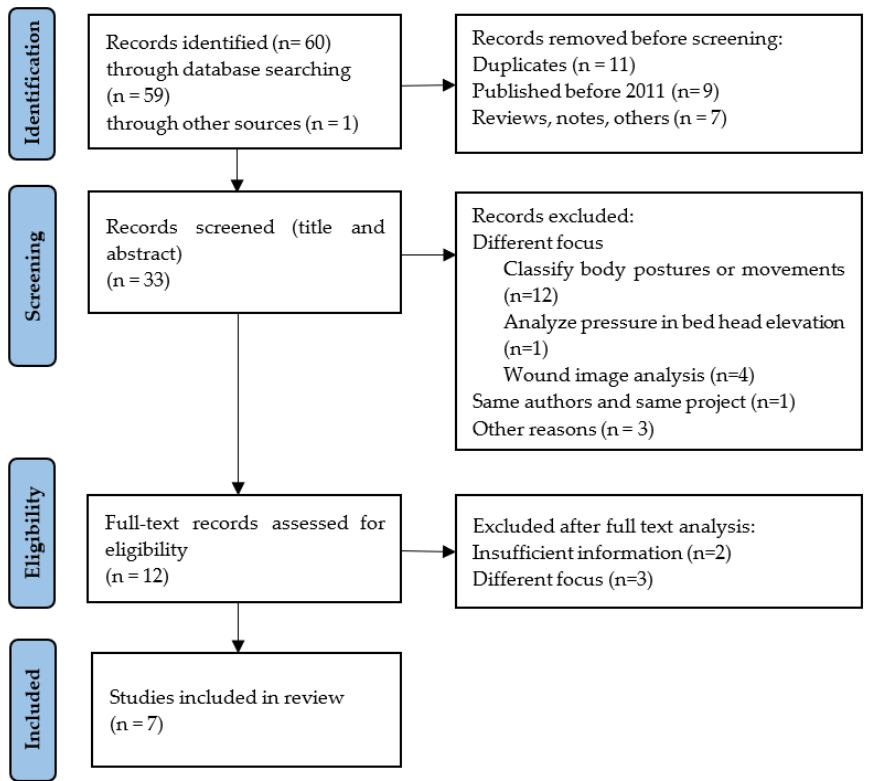
Figure 1. The PRISMA 2020 flow diagram (adapted from [18]) — identification of studies.